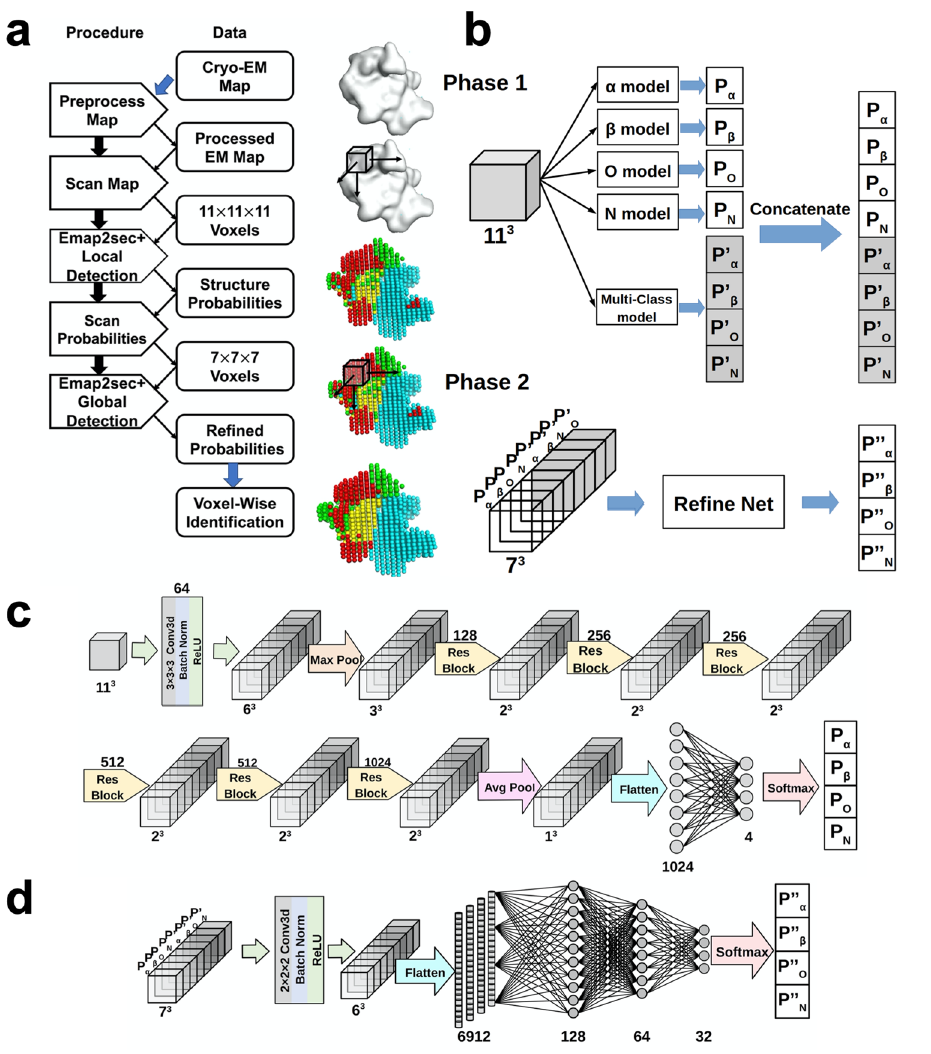
Fig. 1 The network Architecture of Emap2sec + . Emap2sec + scans an EM map with a voxel of 11*11*11Å 3 of size with a stride of 2 and outputs the probabilities that the voxel has α helix, β strand, other structures, or DNA/RNA in the middle of the voxel. It consists of two networks, phase 1 and phase 2, where the phase 2 network re fi nes the initial output by considering assignments given to neighboring 7 × 7 × 7 voxels by the phase 1 network. a logical steps of the pipeline. b the architecture of phase 1 and phase 2 networks. Phase 1 consists of 4 binary classi fi ers and one multi (four) -class classi fi er. The phase 2 network takes outputs from the phase 1 network and outputs re fi ned, fi nal probability values. c a detailed network architecture of phase 1. It uses 6 Residual blocks (Supplementary Fig. 1). d a detailed architecture of phase 2. The main part is a fully